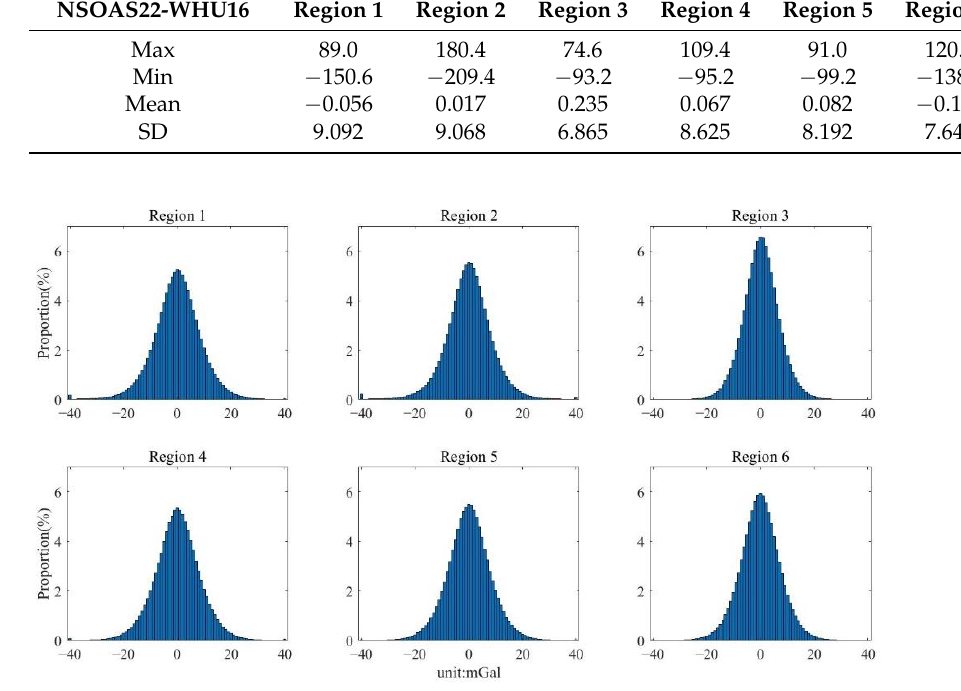
Figure 14. Histogram of the differences between NSOAS22 and WHU16 in the six study regions: Region 1, North Pacific; Region 2, South Pacific; Region 3, Mid-Pacific; Region 4, Indian Ocean; Region 5, North Atlantic; Region 6, South Atlantic. Table 8. Statistics of the differences between NSOAS22 and WHU16 in the six study regions (unit: mGal): Region 1, North Pacific; Region 2, South Pacific; Region 3, Mid-Pacific; Region 4, Indian Ocean; Region 5, North Atlantic; Region 6, South Atlantic.